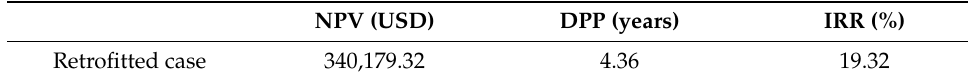
Table 23. Economic results for the retrofitted